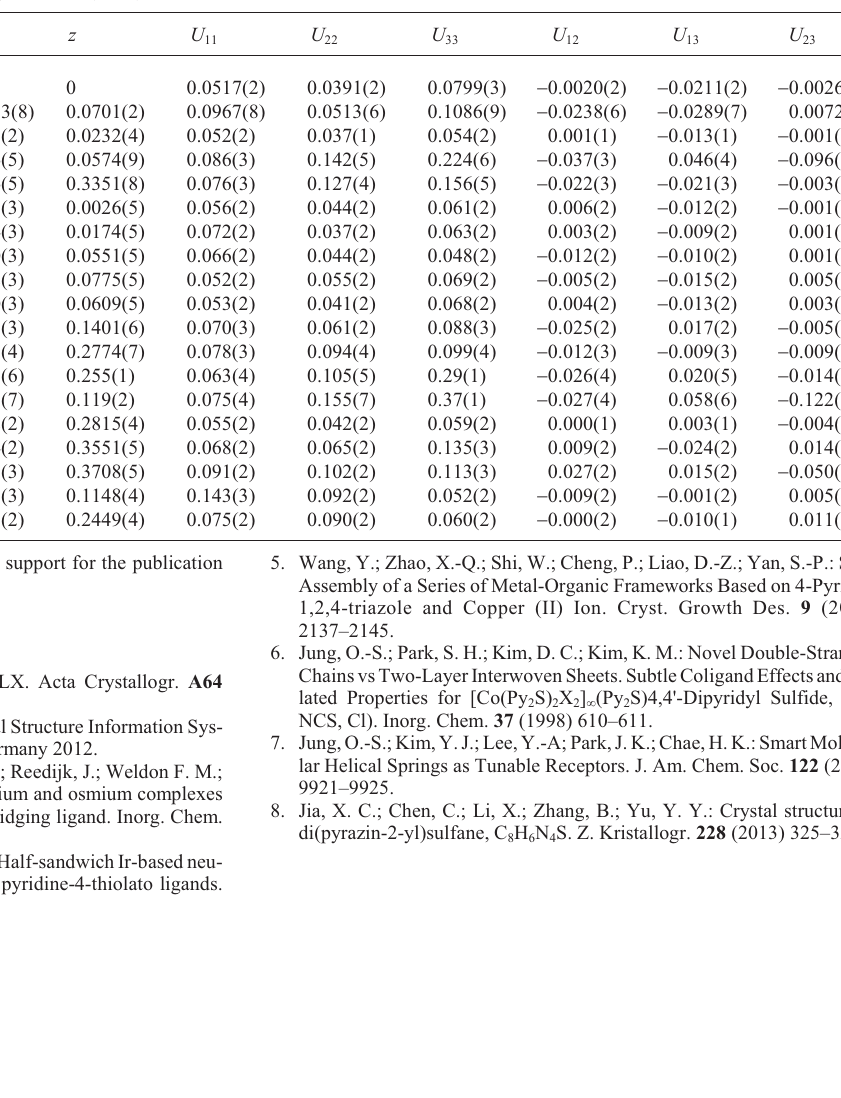
Table 3. Atomic coordinates and displacement parameters (in Å 2 )